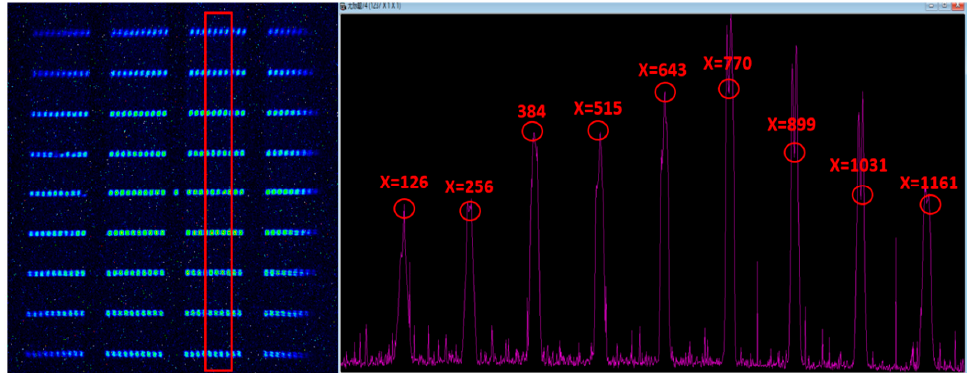
Figure 9. Measurement of transverse magnification: The purple curve in the right figure is the distribution of the average value of intensity along the horizontal direction of the selected part in the red box in the left image, where the abscissa are the pixel positions, and the ordinate is the intensity value. The red numbers represent the pixel coordinates of the positions shown in the red circles.